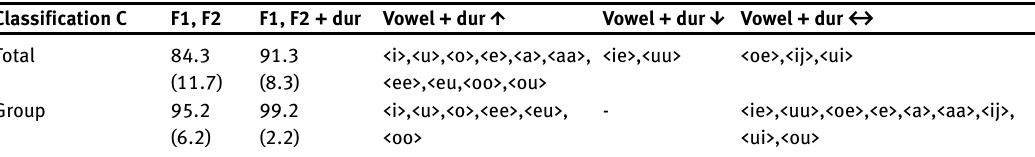
Table 7. Scores for the canonical classifications of the Dutch vowels produced by native Dutch speakers for the conditions “Total” and “Group”, with both F1 and F2 (25%, 50%, 75%) only, and F1, F2 and duration, and target vowels whose percentages (do not) change after including duration, deviations ≤ 2.5% after including duration are rated as unchanged; Classification C = classification condition, + dur = including duration.